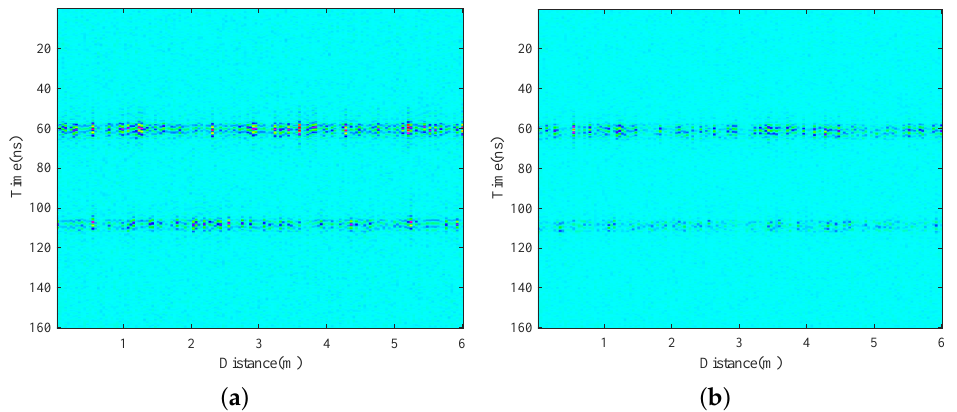
Figure 16. Simulated profiles of IMF1 and IMF2 combined after WOA-VMD-BD processing. ( a ) HH polarization mode. ( b ) HV polarization mode.